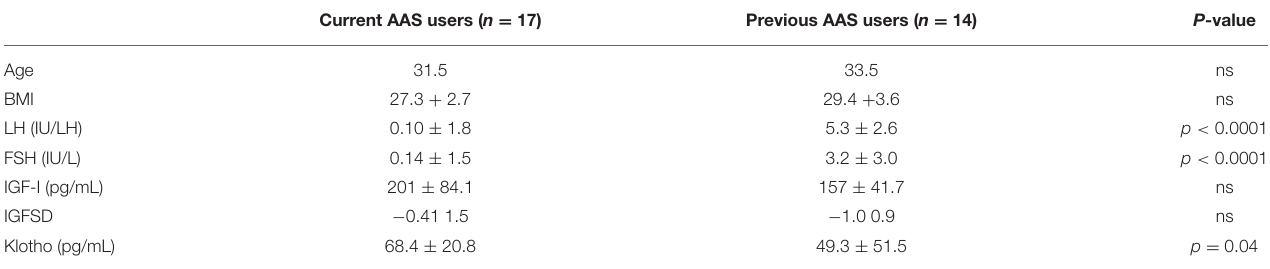
TABLE 1 | General characteristics, and hormone values in men with an ongoing AAS ( < 2 months) and previous AAS (2–12